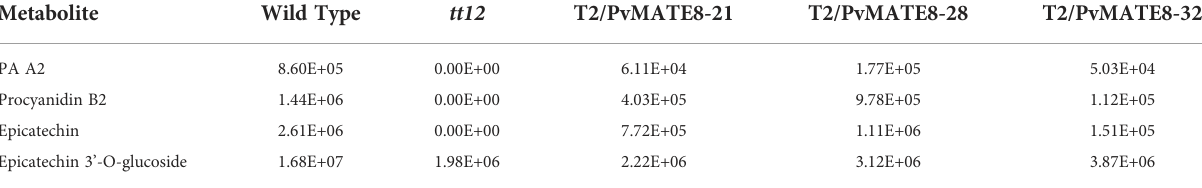
Data represent average of 5 biological